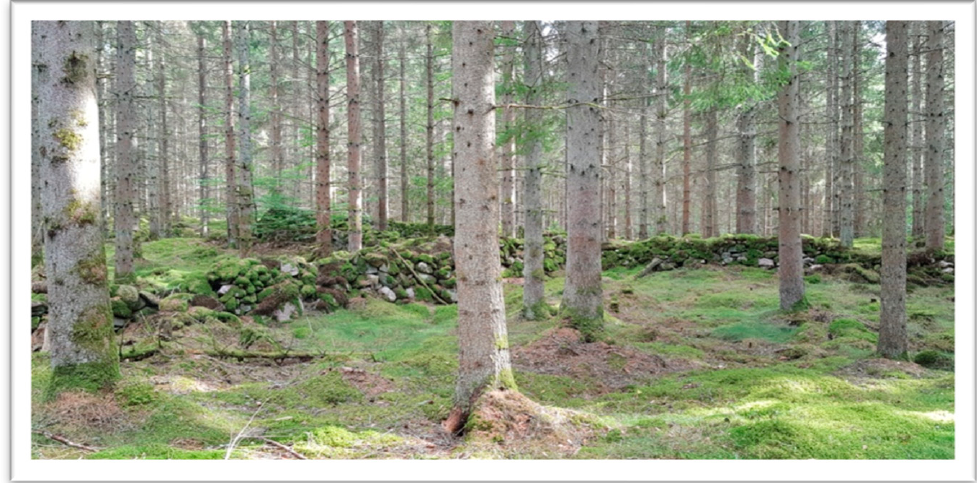
Figure 4. Spruce and stone fences in Kullaskogen. [Photo: Marianne Larsson].